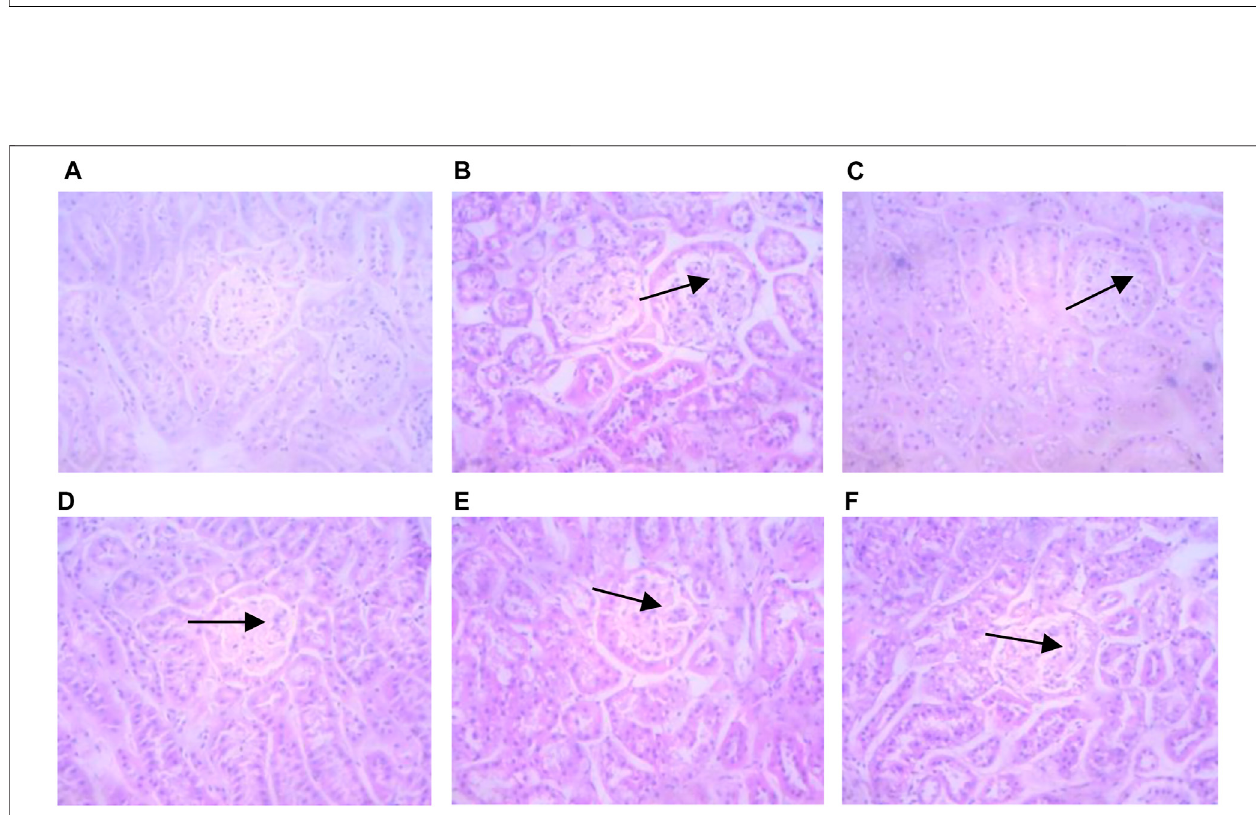
FIGURE 4 | Kidneys pathological sectioning of various groups (HE ×400). Control group (A) ; model group (B) ; high dosage (C) ; medium dosage (D) ; low dosage (E) ; Huangqi Liuyi decoction (F) .